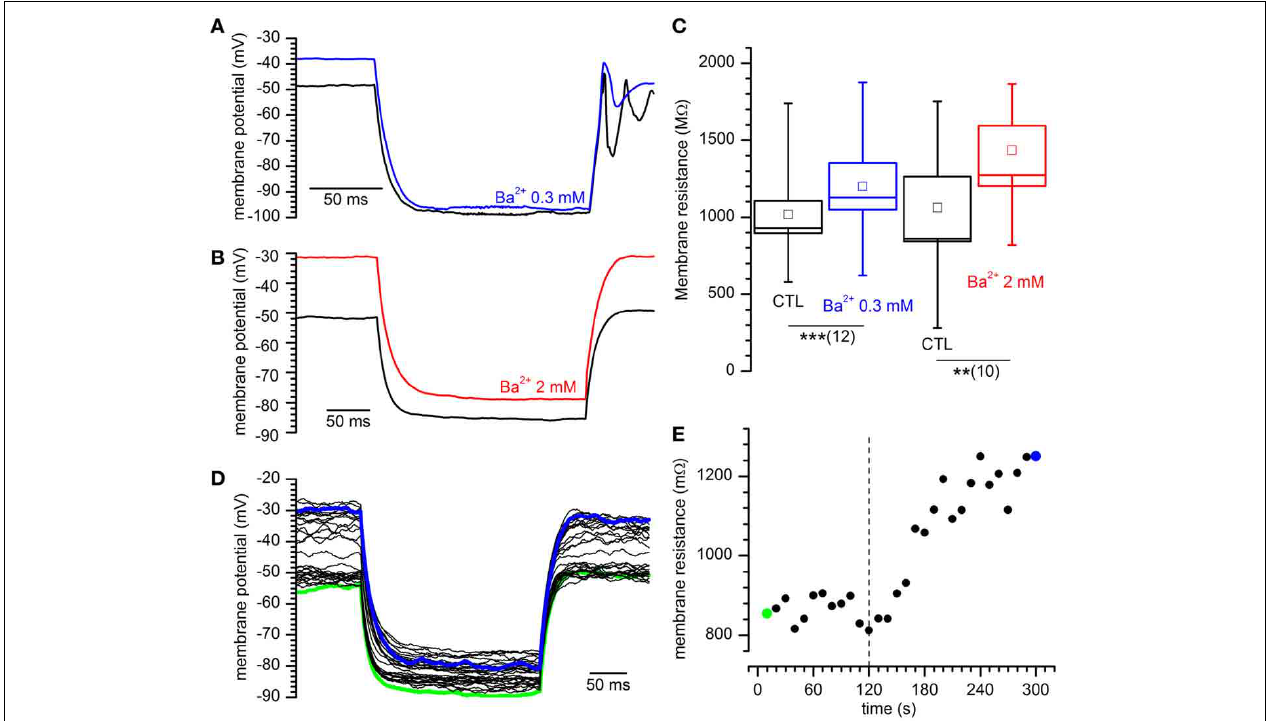
FIGURE 5 | Effect of different concentrations of Ba 2 + on input resistance. (A,B) Sample tracings showing the response to the injection of 40pA in current-clamp conditions for the indicated external Ba 2 + concentrations. (C) Increase of input resistance at the indicated external Ba 2 + concentrations: + 17.8 ± 3.2%, n = 12, and 58.7 ± 14.2%, n = 10 in 0.3 and 2mM external [Ba 2 + ]o with respect to controls. ∗∗ and ∗∗∗ indicate significance levels of 0.01